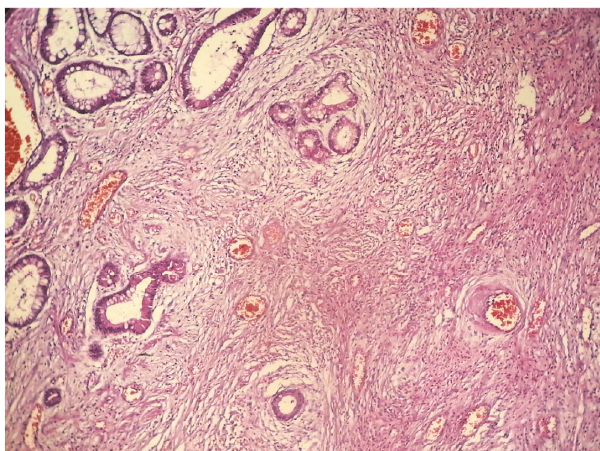
Figure 3: Hematoxylin and eosin (H&E) stain demonstrating a mucosal and submucosal spindle cell proliferation showing an “onion-skin” disposition around the abundant blood vessels.